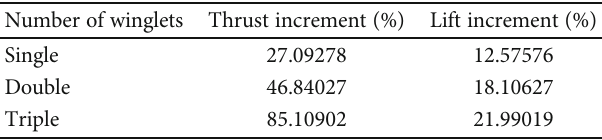
Table 3: Aerodynamic increment comparison of di ff erent pieces of winglets with no